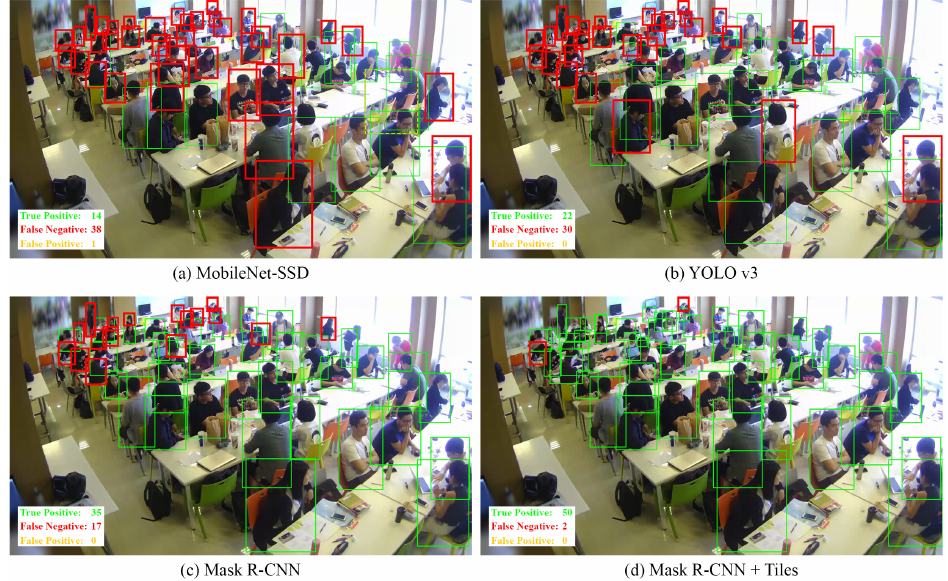
Figure 10. Comparison of MobileNet-SSD, YOLO v3, Mask R-CNN, and Mask R-CNN + Tiles detection schemes for reading room